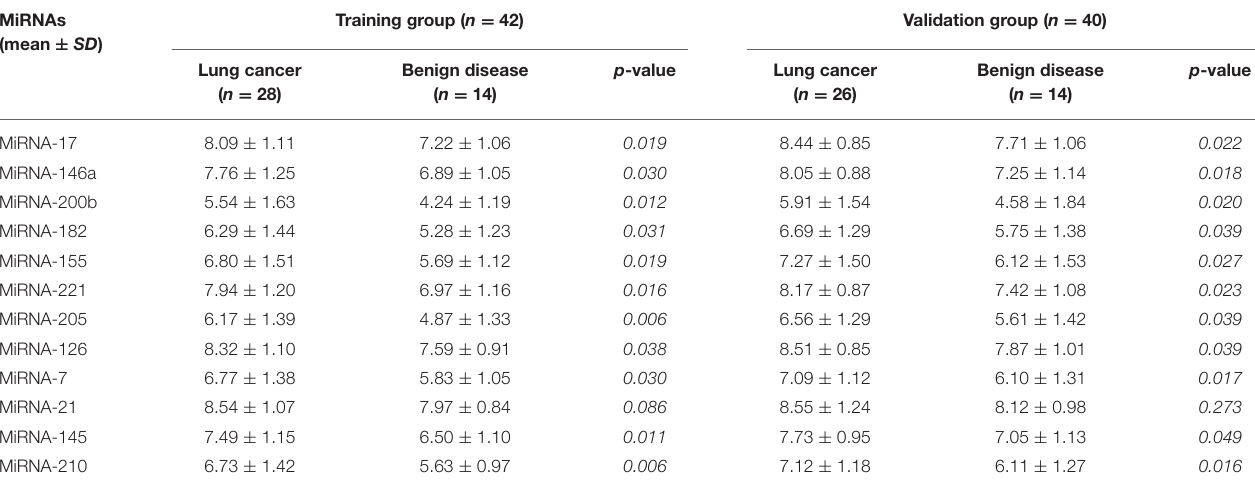
TABLE 2 | Concentration of each miRNA in the training and validation groups. MiRNAs (mean ± SD